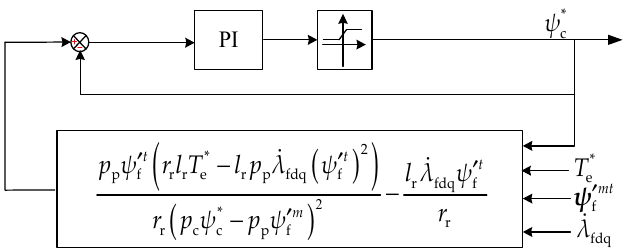
Figure 7. Block diagram of closed-loop feedback solution for Equation (37). So far, the control system block diagram of the slip-frequency type realization of the feedback linearization and the MTPA control of the cup rotor permanent-magnet doubly fed machine is shown in Figure 8. The output of the speed loop is the torque reference value, and the rotor flux reference value of the control machine is obtained by the MTPA control. The synchronization angle used for the rotation transformation is obtained by ω of the machine and the slip angular speed integrating the sum of the angular speed r